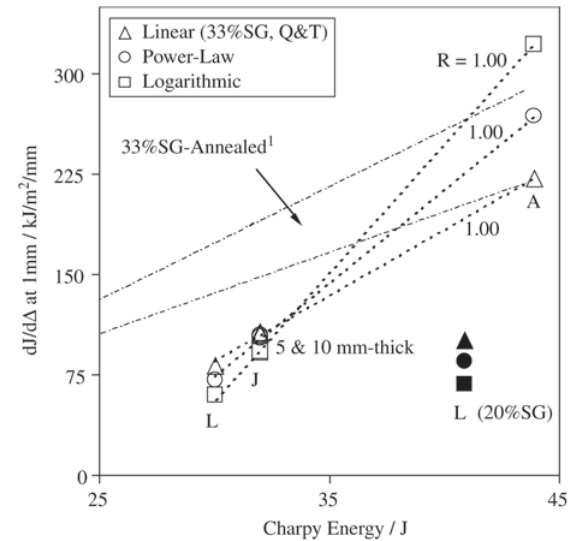
Figure 5. Correlation between quasi-static and dynamic fracture toughness parameters. J-R testpieces are 10 mm-thick, otherwise stated. Charpy and J-R specimens are 33% side-grooved, other- wise